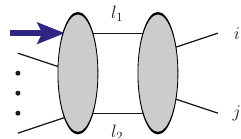
Figure 5. Unitarity cut for one-loop minimal form factors in gauge